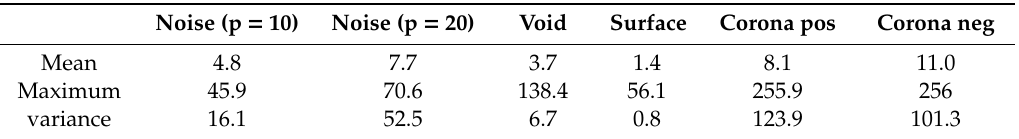
Table 1. Pulse magnitude statistics for normal data at the strong peak noise signal amplitude parameter value of 10 and 20 and the PD data of four PD types. Noise (p = 10) Noise (p = 20) Void